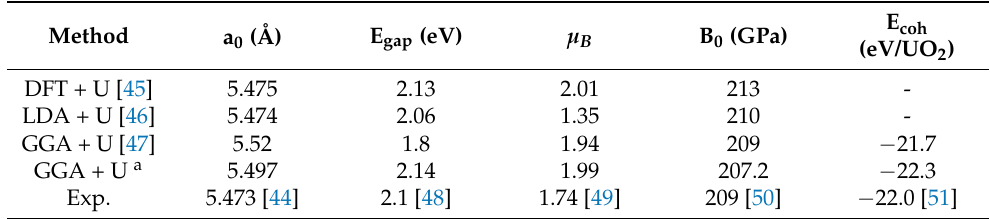
Table 1. Lattice parameter (a 0 ), band gap (E gap ), magnetic moment ( µ B ), bulk modulus (B 0 ), and cohesive energy (E coh ) of the UO 2 at the ground state, compared to the reported experimental values